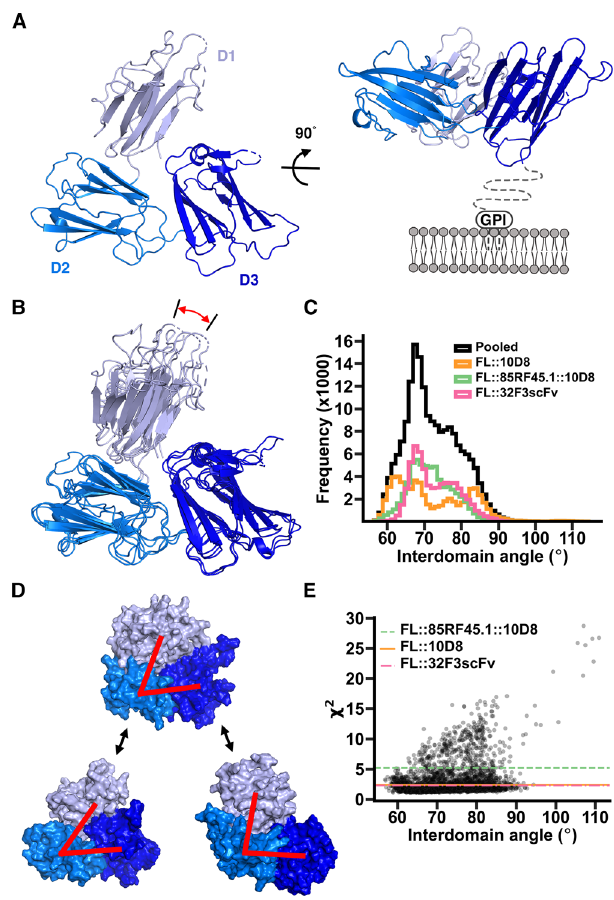
Fig. 3 | Structure and dynamics of Pfs48/45. A The structure of Pfs48/45 taken from that of full-length Pfs48/45 bound to 10D8, viewed from two different directions. TheN-terminal(D1),central(D2)and C-terminaldomains(D3)are light, medium and dark blue. The right-hand panel also indicates the membrane and the 20 residue long linker not included in our constructs. B Comparison of the three full-length Pfs48/45 structures. Three structures were constructed by taking the modelsofPfs48/45fromthethreedifferentcrystalstructuresofPfs48/45boundto different antibody combinations and aligning the structure of the N-terminal domain onto the fragments of the domain built into the electron density. These composite structures have been aligned based on the central and C-terminal domains, showing the motion of the N-terminal domain, highlighted by the red arrow. C Histogram showing the observed interdomain angles in full-length Pfs48/ 45 during atomistic molecular dynamics simulations. To de fi ne these angles two linesweredrawn,linkingthecentresofmassoftheN-terminalandcentraldomains and those of the central and C-terminal domains. The angleshown is thatbetween theselines.Thethreecolouredhistogramsrefertooutcomesofthreeindependent simulations which started with the models in panel ( B ) with histograms being constructed by pooling fi ve replicates for each starting structure. The black his- togramisthepooleddistributionofallreplicatesinallthreestartingmodels. D The average angle observed in the simulations from ( C ). is shown top-centre with the most closed observed model bottom-left and the most open model bottom-right. Red lines are as described in C . E shows the fi tting of models from the molecular dynamic simulations to data from small angle X-ray scattering. Each point repre- sents a different model and the χ 2 gives the quality of fi t to the scattering curve. Horizontal lines show the χ 2 for the fi t corresponding to interdomain angles found in the three crystal structures, as seen in B